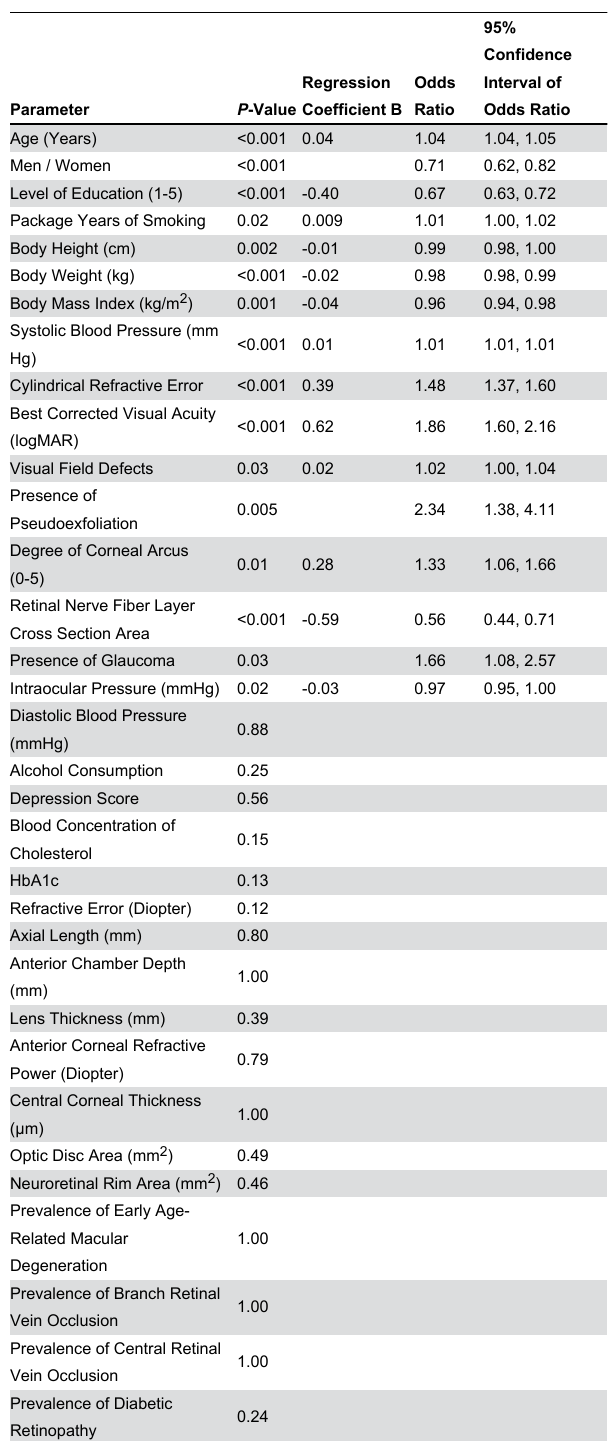
Table 2. Associations (univariate analysis) between the presence of pterygium and systemic or ocular parameters in the Central India Eye and Medical Study.